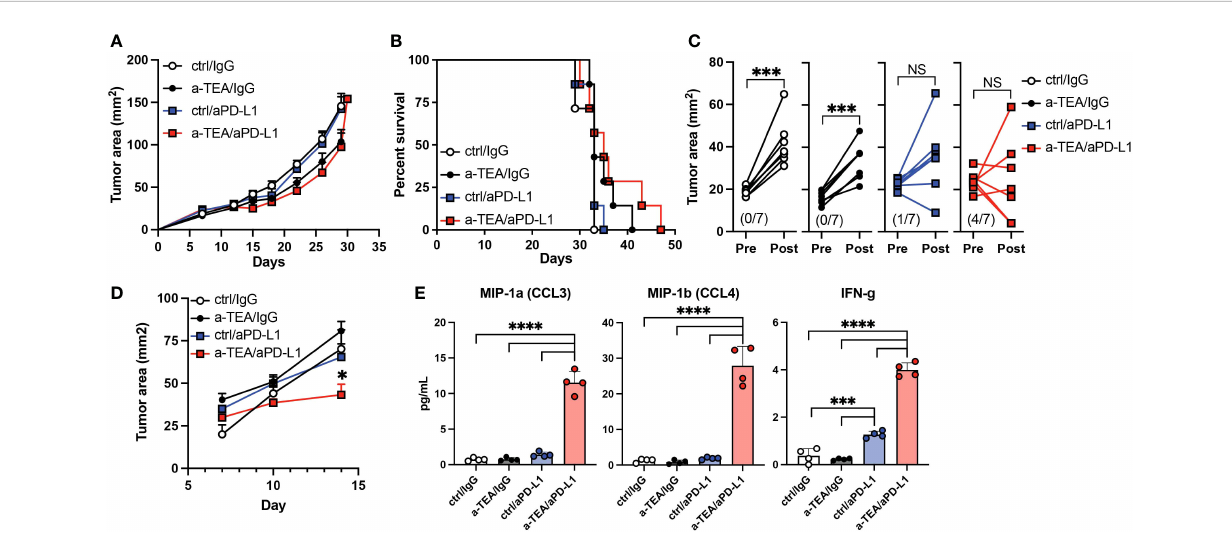
FIGURE 2 Impact of combined a-TEA-LS plus aPD-L1 ICB on tumor growth and T cell differentiation. (A-E) 4T1 mammary carcinoma tumor-bearing mice were treated with control diet, IgG (ctrl Ab), a-TEA-LS, and/or aPD-L1 and then (A) tumor growth (mean+SD) and (B) survival were determined. (C) Maximum change in tumor size was determined pre- and post-treatment in the indicated treatment groups. Each dot represents an individual mouse. The total number of mice per cohort exhibiting a reduction in tumor size (post-treatment) is depicted in parentheses. ***P<0.001 by paired t test. (D) Tumor growth of 4T1 tumor- bearing mice treated as described above and then (E) CD8 + T cells were isolated from the lymph nodes 8 days following treatment. Cells were restimulated with aCD3 for 24 hours in vitro and then supernatants were collected and protein expression determined by multiplex ELISA. Each dot represents an individual mouse. Graphs represent the mean and range from 4 mice per group from 1 of 2 independent experiments. *P<0.05, ***P<0.001, ****P<0.0001 by 1-way ANOVA. NS, not signi fi